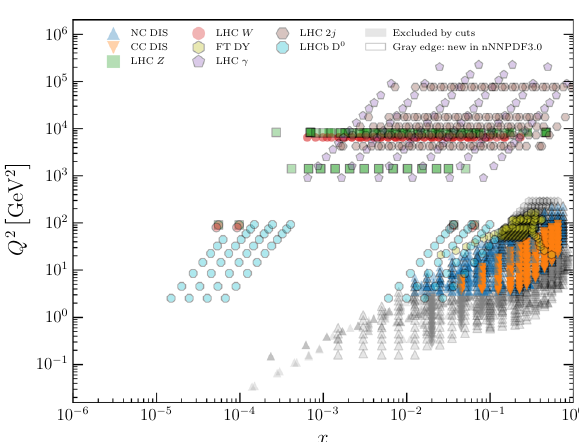
Fig. 1 Thekinematiccoverageinthe ( x , Q 2 ) planeofthenNNPDF3.0 dataset. The evaluation of x and Q 2 for the hadronic processes assumes LO kinematics. Data points are classified by process. Data points new in nNNPDF3.0 in comparison to nNNPDF2.0 are marked with a grey edge. Data points excluded by kinematic cuts are filled grey